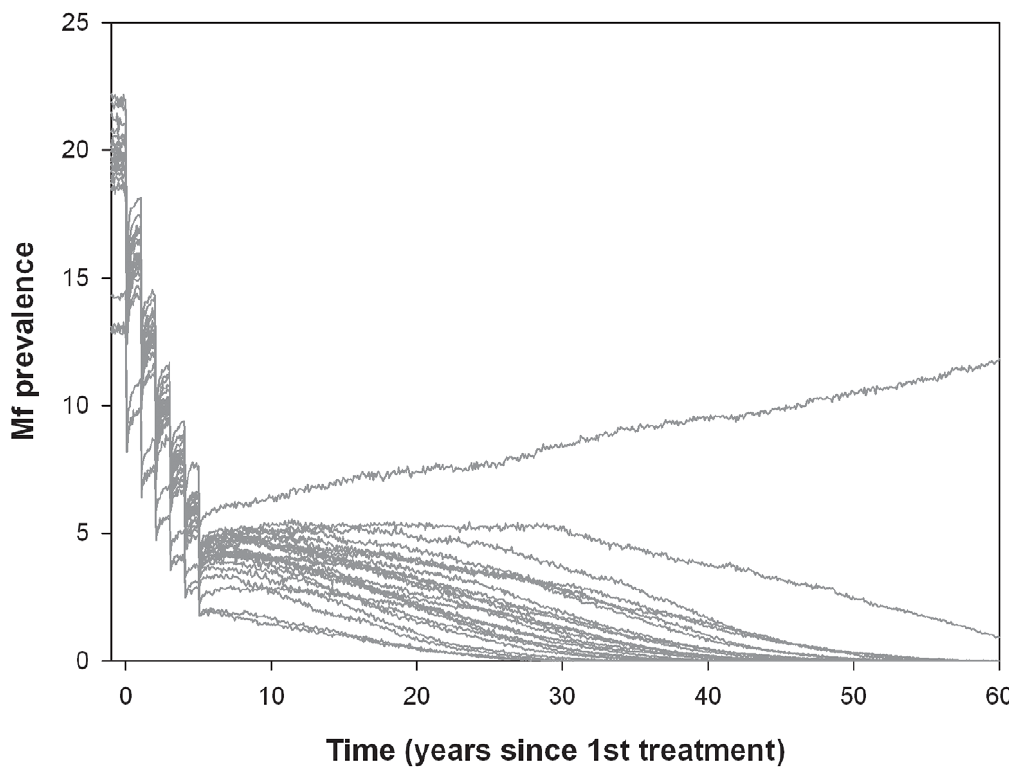
Figure 1. Simulated trends in mf prevalence (%) after mass drug administration. The presented trends are for an African setting with pre- control mf prevalence around 20%, where 6 rounds of annual mass drug administration with IVM + ALB were provided starting at time 0. Coverage was 70% and drug efficacy was quantified according to our baseline assumptions. The figure displays the trend of 25 runs, simulated by LYMFASIM, all with the same input assumptions. Variation in the outcomes is due to